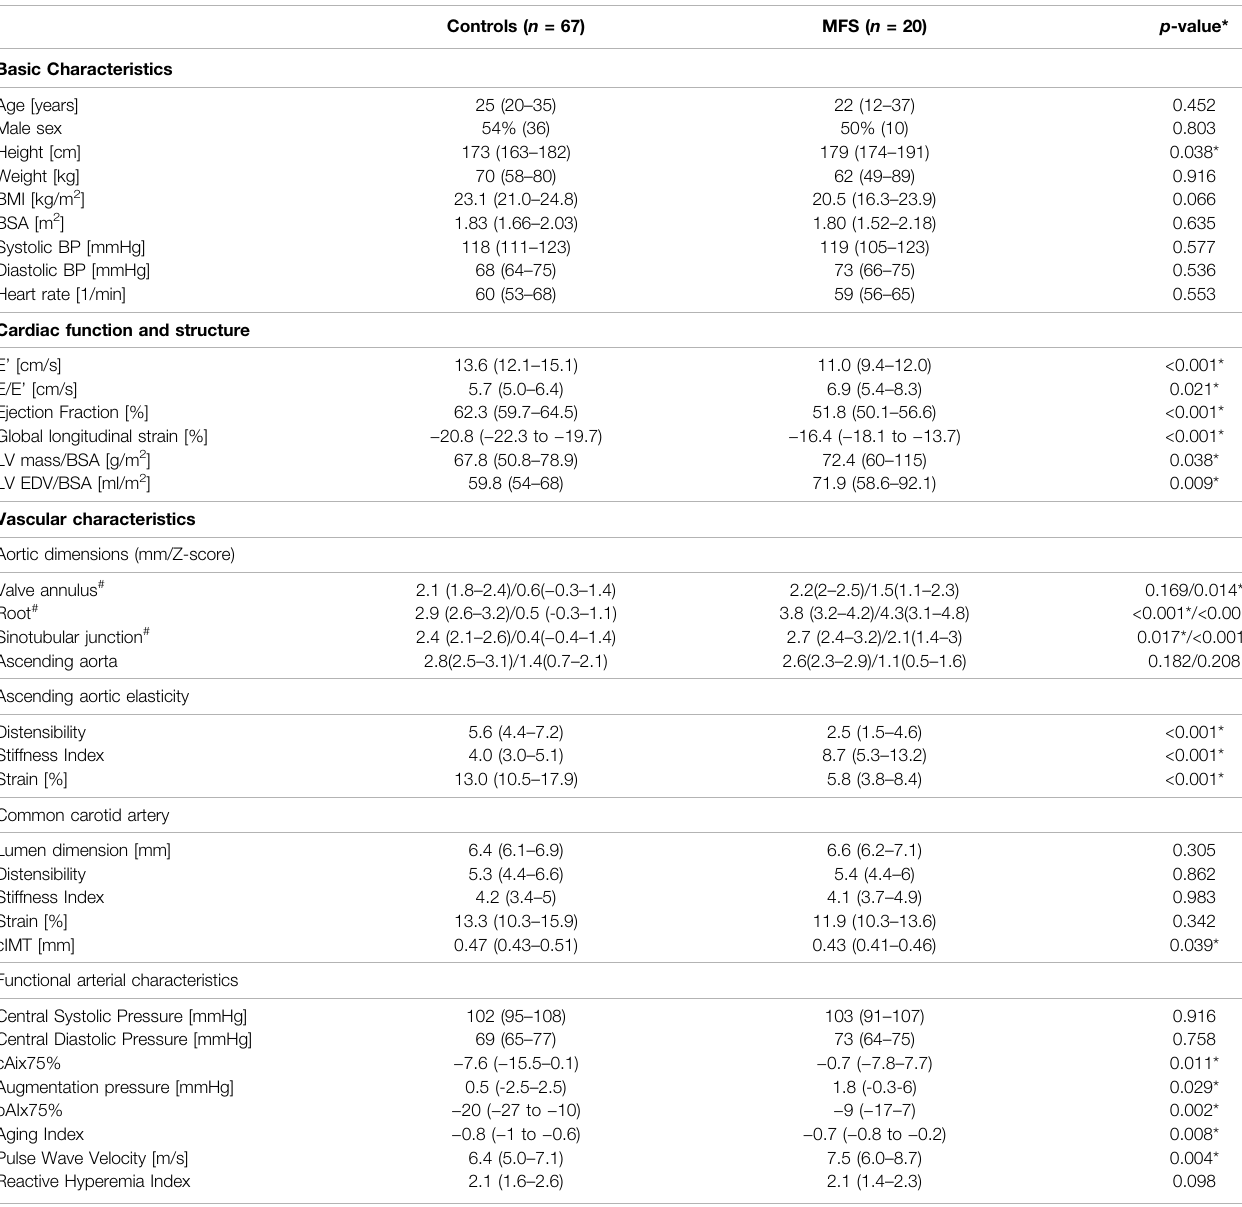
TABLE 1 | Descriptive statistics comparing basic characteristics and outcome variables of Controls to MFS patients Continuous variables are presented as median (interquartile range) and categorical variables as percent (number). Controls ( n =